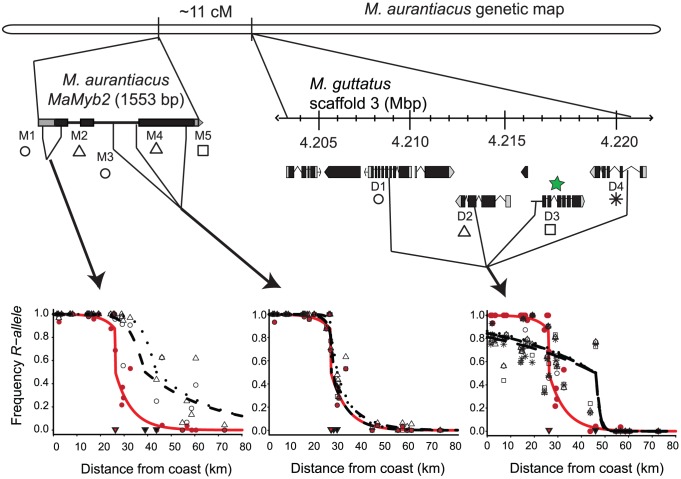
Spatial variation in selection among SNPs surrounding the flower color locus.In all plots, the red curve denotes the cline in flower color estimated from phenotypic data, and black curves denote the allele frequency clines for SNPs. Genetic markers are grouped according to results of pairwise likelihood ratio tests (Figure 7), with each panel combining groups of markers that are not significantly different from each other (left: M1 and M2; center: M3–M5; right: D1–D4). The frequency of red flowers in each population is plotted as red circles in each panel and the frequency of the R allele at each SNP in each population is plotted as different black symbols (as indicated below each marker name). Filled triangles indicate the cline center for each SNP (black) and flower color (red) as estimated using maximum likelihood (see Table S6 for parameter estimates). Details of marker positions and maps are the same as in Figure 4. Functional annotations for the genes containing markers D1–D4 are described in Table S3.